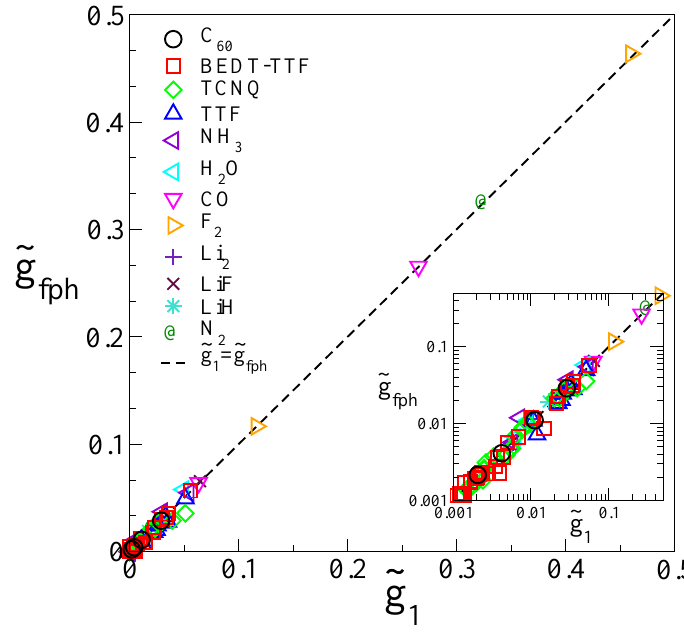
and every vibrational